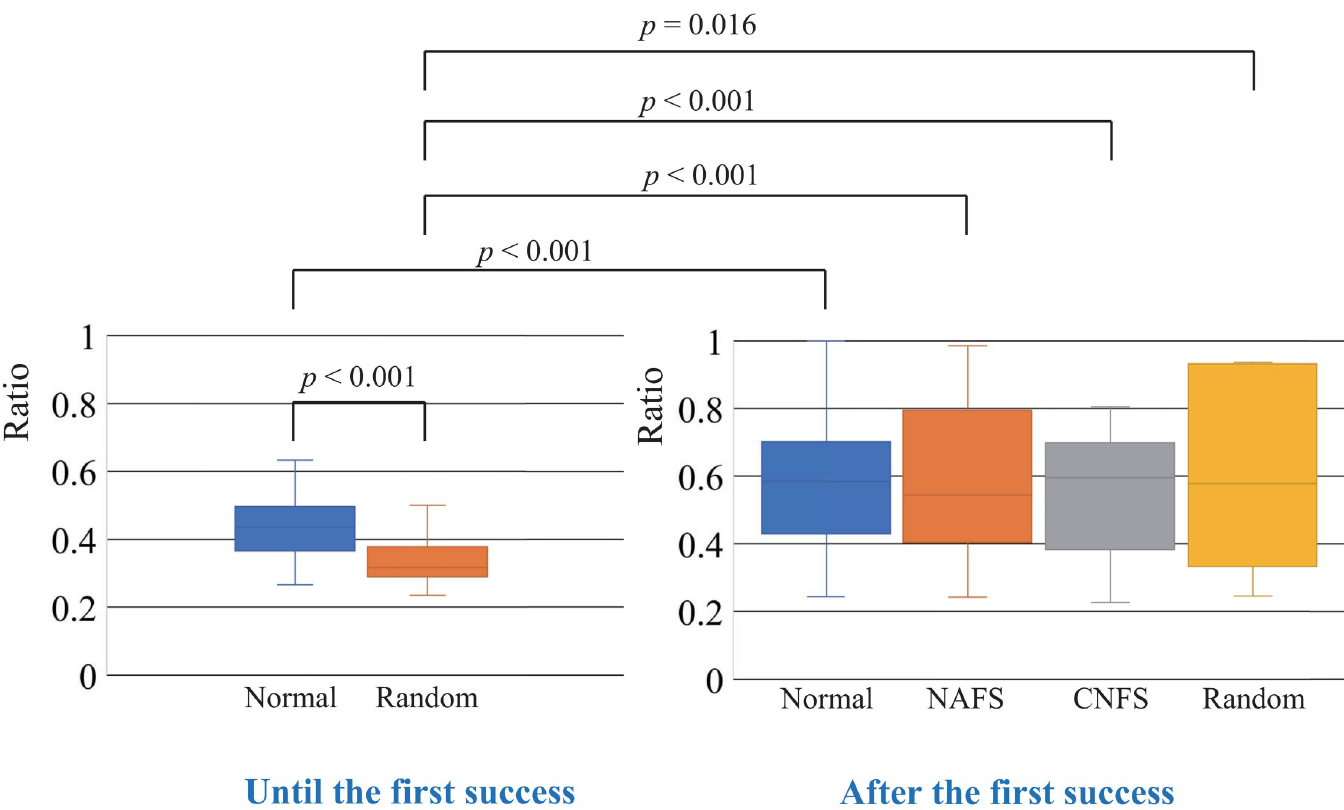
Fig 10. Ratio of the top-three commands used to the total number of commands used. The left part of the figure shows the ratio for achieving the first success of the shift task, and the right part shows the ratio from the first success to the timing when achieving the terminal condition.